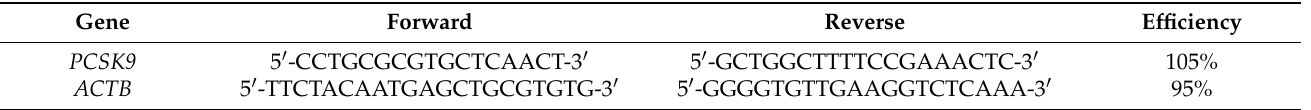
Table 1. Primer sequences and